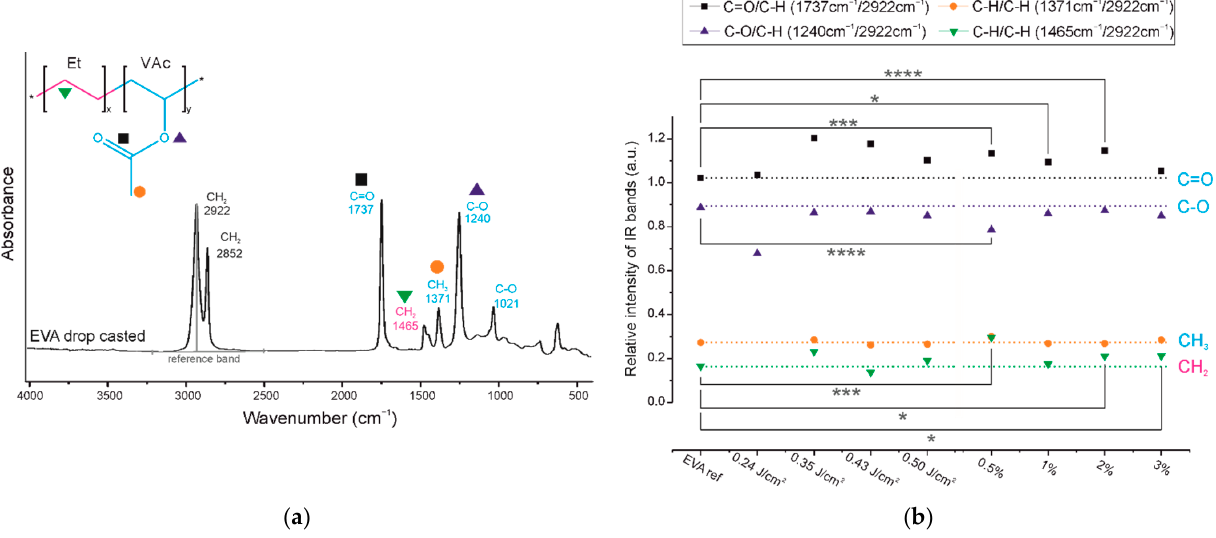
Figure 4. ( a ) FTIR spectrum of reference EVA coating with marked and assigned reference and characteristics. ( b ) Relative intensity of IR bans of two series of EVA films (statistical difference between reference and particular coating * p = 0.02, *** p = 0.0001, **** p < 0.0001).